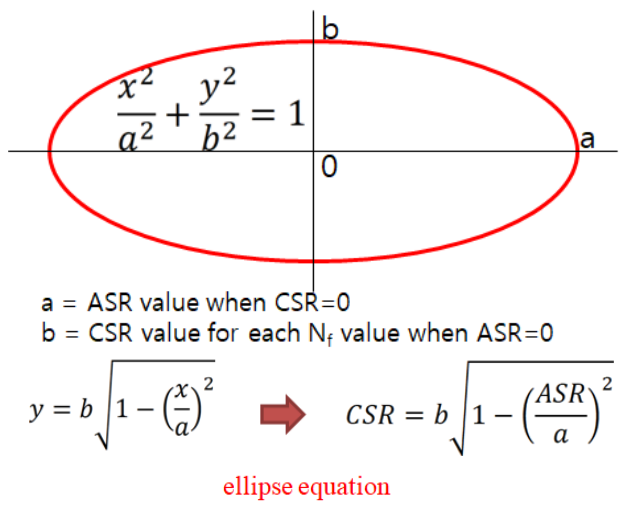
J. Mar. Sci. Eng. 2020 , 8 , x FOR PEER REVIEW Figure 10. Graph matching of the design curve and elliptic graph. Figure 10. Graph matching of the design curve and elliptic graph.